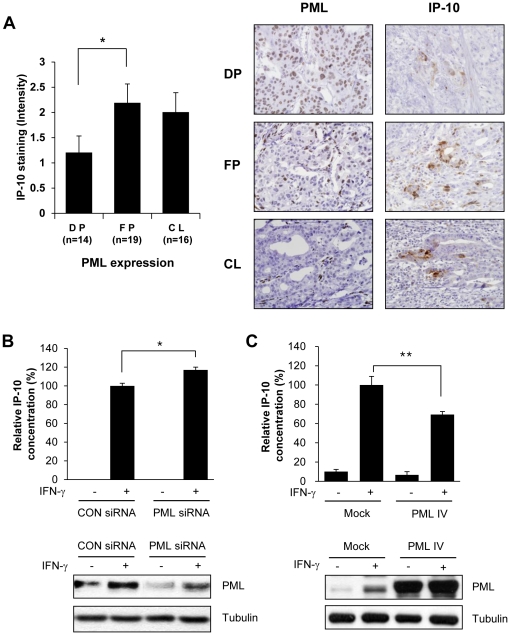
PML Protein Expression is Inversely Correlated with the Level of IP-10.(A) Immunohistochemical staining for PML and IP-10 protein expression was performed for 49 cases of stage IV advanced gastric carcinomas. Immunopositivity for PML protein was categorized as diffuse positivity (DP; nuclear immunoreactivity in ≥50% of tumor cells), focal positivity (FP; in ≥10% but <50%), or complete loss (CL; in <10%). For quantitative analysis of immunoreactivity of IP-10, positively stained areas were measured using an ImageJ software program as described in Materials and Methods. Representative images show PML and IP-10 protein expression in advanced gastric carcinoma tissues (right). (B) SNU-638 cells were transiently transfected with Pml siRNA or control siRNA. Two days after transfection, cells were incubated in the absence or presence of IFN-γ (10 ng/ml) for 8 h. IP-10 protein from the culture supernatants was analyzed by ELISA and normalized by the cell protein concentration. The relative concentration was calculated as the normalized amount divided by the normalized amount of SNU-638 cells which were transiently transfected with control siRNA in the presence of IFN-γ, and the concentration from parental cells was arbitrarily set at 100%. (C) SNU-638 gastric cancer cells were transiently transfected with either empty vector or PML IV expression vector. Day after transfection, cells were treated with or without IFN-γ (10 ng/ml) for 8 h and culture supernatants were obtained and subjected to ELISA as described in B. PML protein expression was verified for each assay by immunoblotting. Data shown are representative of at least three experiments. Bars, SD. *P<0.05, **P<0.01.